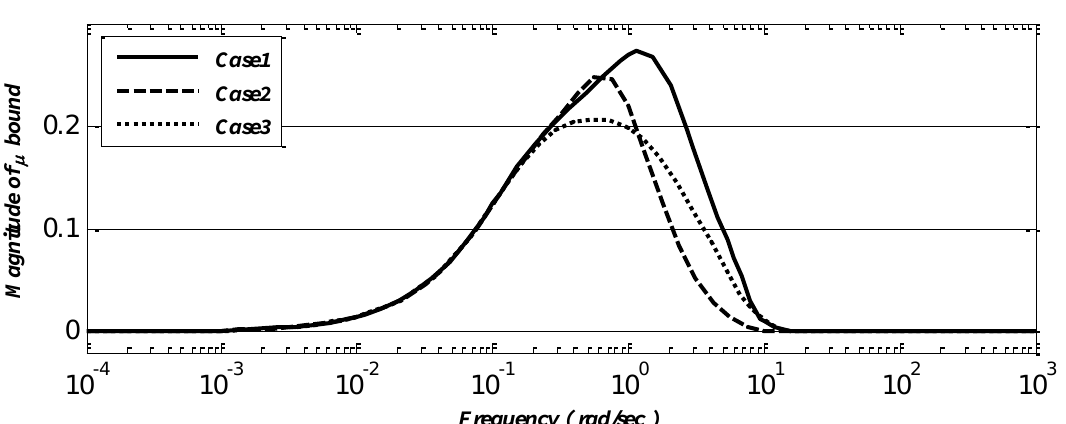
Figure 13a. μ bound of the closed-loop stability with designed local